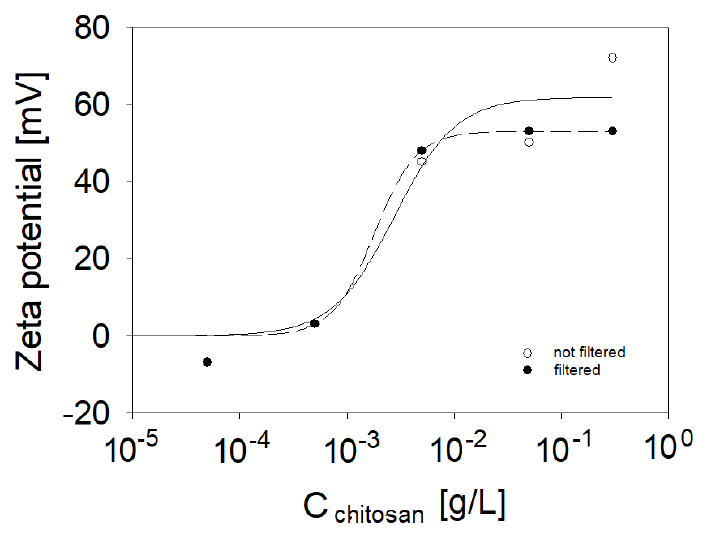
Figure 3. Zeta-potential for saponin or saponin–chitosan aggregates in mixtures. Fixed saponin concentration of 0.1 g/L in the presence of 1%wt. acetic acid. Chitosan concentrations varied in a range from 0.0005 to 0.5 g/L. Solid and dashed lines guide the eye (solid line show the not filtered aggregates, dashed—filtered).